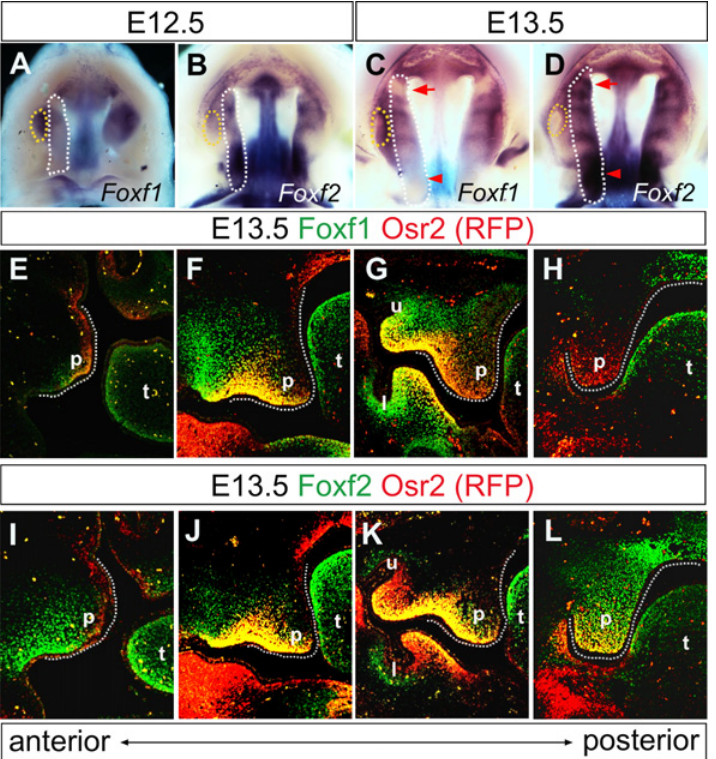
Fig 6. The patterns of Foxf1 and Foxf2 expression during palate development. (A-D) Whole-mount in situ hybridization detection of Foxf1 (A, C) and Foxf2 (B, D) mRNAs in the developing palate shelves in E12.5 (A, B) and E13.5 (C, D) mouse embryos. White dashes demarcate the palatal shelf on the right side. Yellow dashes mark the molar tooth germ. (E-H) Immunofluorescent staining of Foxf1 (green) and RFP (red) on sections from the anterior to posterior regions of the palatal shelves in E13.5 Osr2 RFP/+ embryos. (I-L) Immunofluorescent staining of Foxf2 (green) and RFP (red) on sections in E13.5 Osr2 RFP/+ embryos. p, palatal shelf; t, tongue; l, lower molar; u, upper